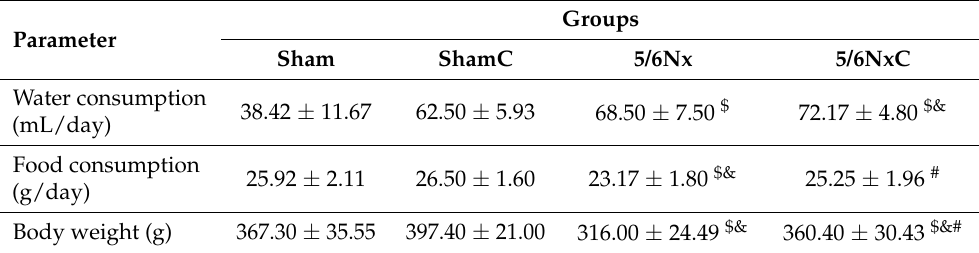
Table 1. General